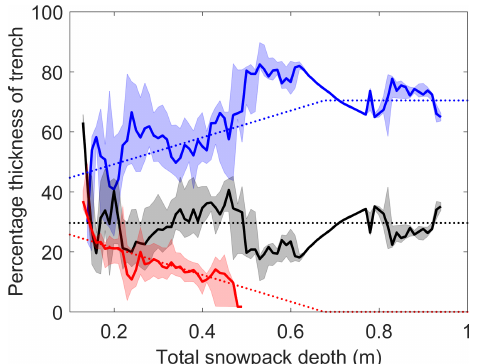
Figure 7. Relative change in thickness of snowpack layers with total depth: median (solid) and interquartile range (shaded) of surface snow (red), wind slab (blue), and depth hoar (black) layers. Dotted line describes the dependence of layer thickness on depth based on linear trend line fits. Layer thickness data from 2013 trenches only.